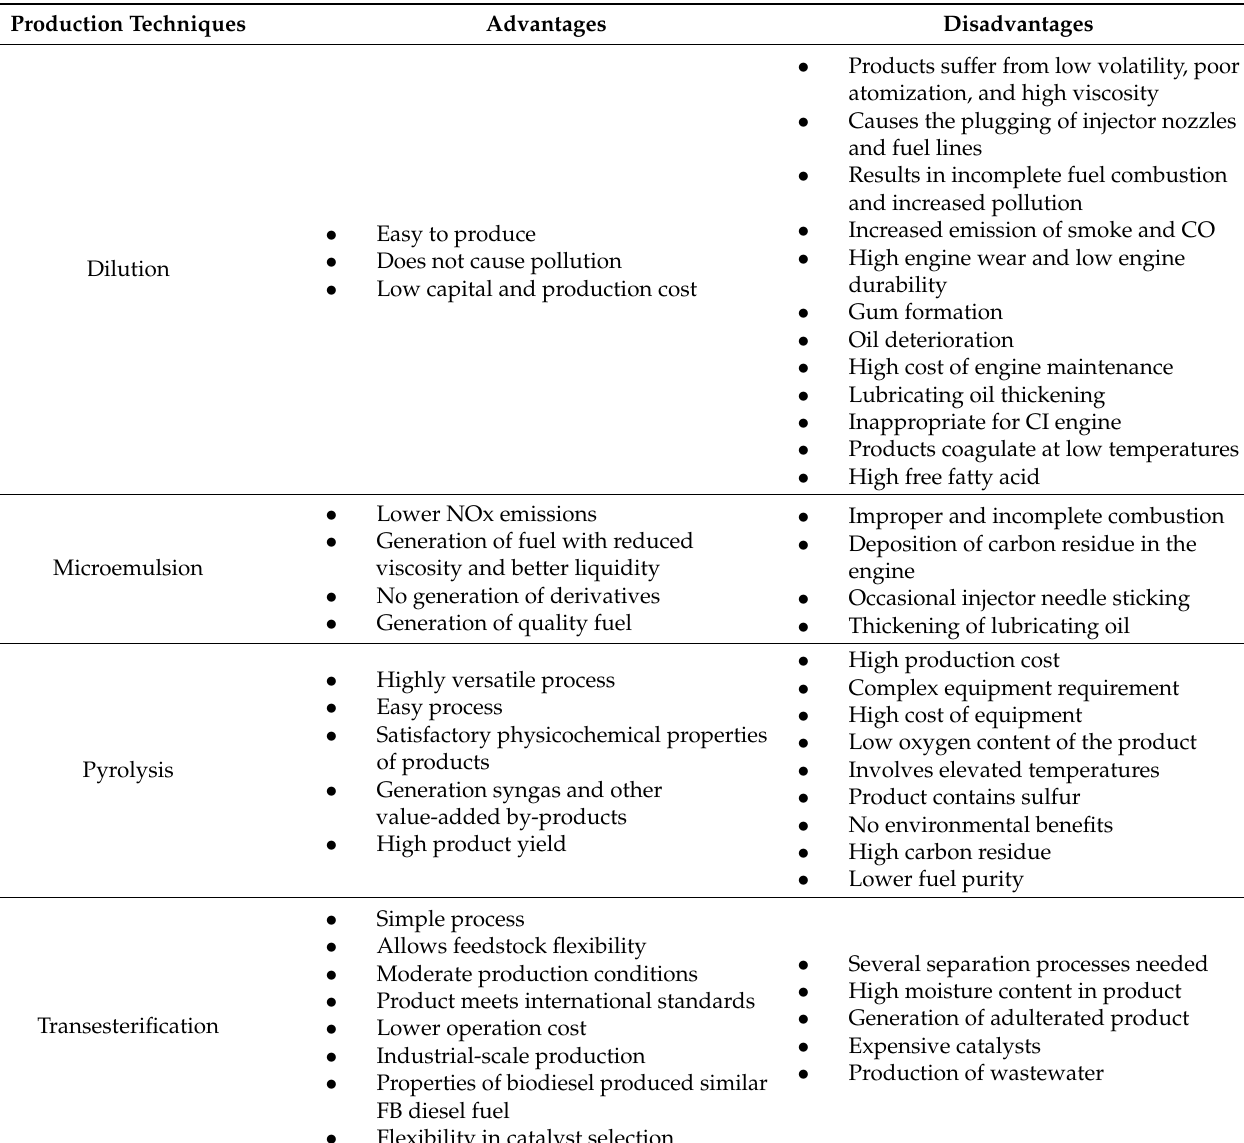
Table 4. Advantages and disadvantages of biodiesel production techniques